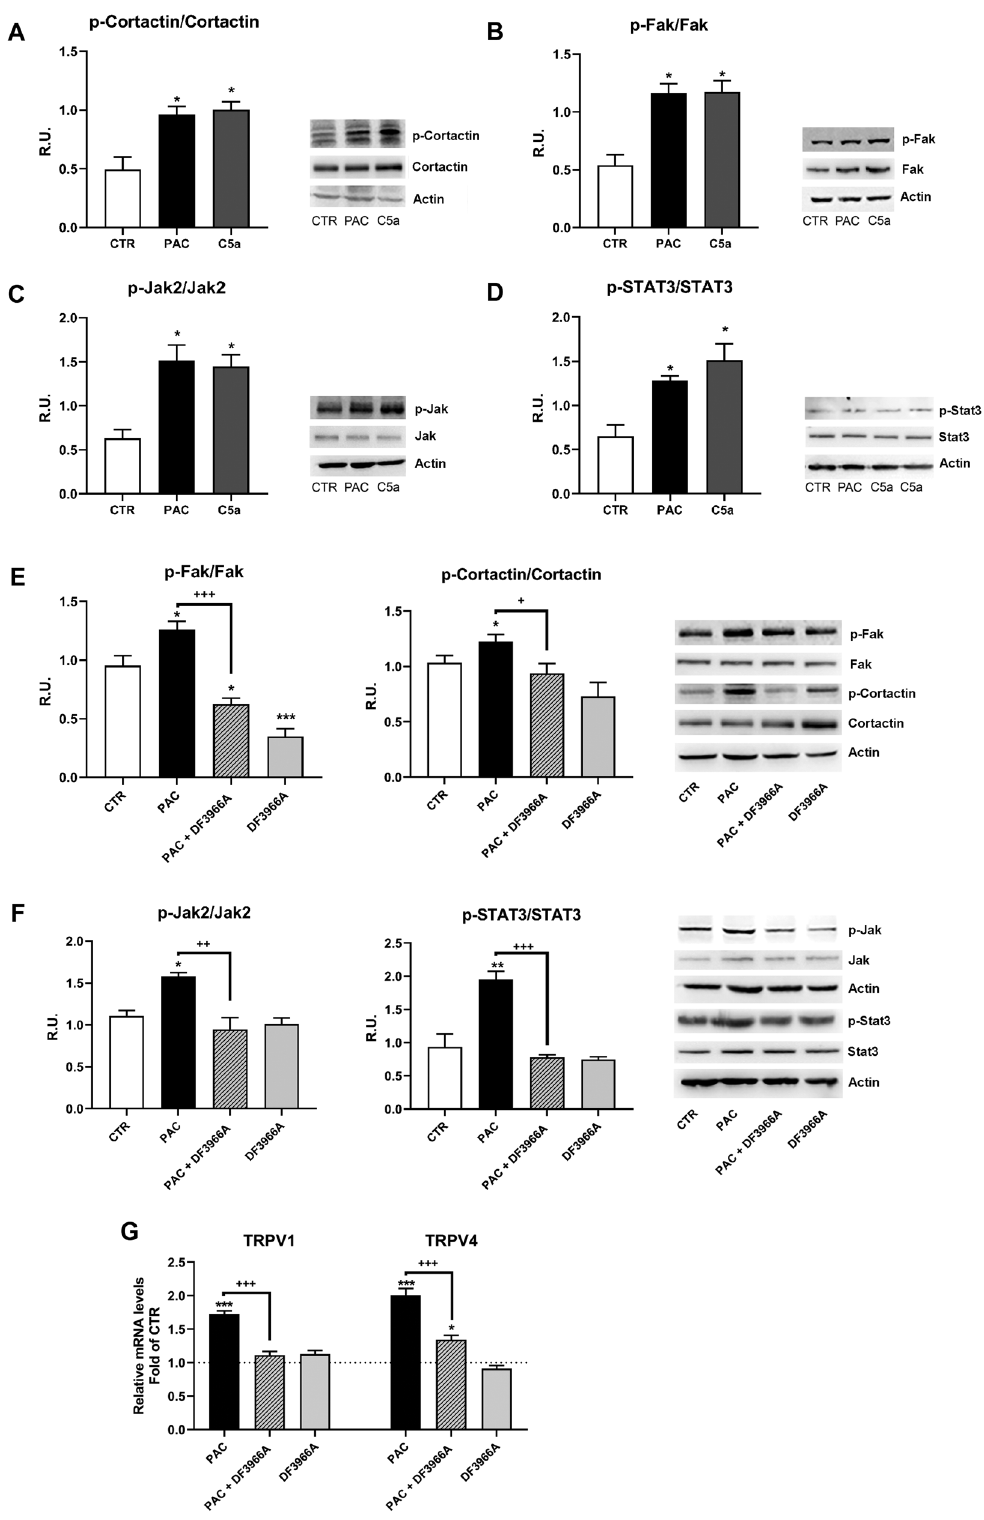
Fig. 4 C5aR1 inhibition restores neuronal plasticity in paclitaxel-treated F11 cells. Quanti fi cation of the expression of phosphorylated and total forms of p-cortactin ( A ), p-FAK ( B ), p-JAK2 ( C ) and p-STAT3 ( D ) in differentiated F11 cells following paclitaxel (PAC) or C5a treatment evaluated by western blot analysis. Expression of p-cortactin and p-FAK ( E ), p-JAK2 and p-STAT3 ( F ), and TRPV1 and TRPV4 ( G ) in differentiated F11 cells exposed to paclitaxel and treated or not with a C5aR1 inhibitor, DF3966A. F11 cells were treated for 24 h with PAC (10 nM), C5a (50 nM) or DF3966A (10 µM) or PAC (10 nM) + DF3966A (10 µM). *** P < 0.0005; ** P < 0.005; * P < 0.05 vs CTR; +++ P < 0.0005; ++ P < 0.005; + P < 0.05 vs paclitaxel. Data are mean ± SEM of n = 3 different experiments.